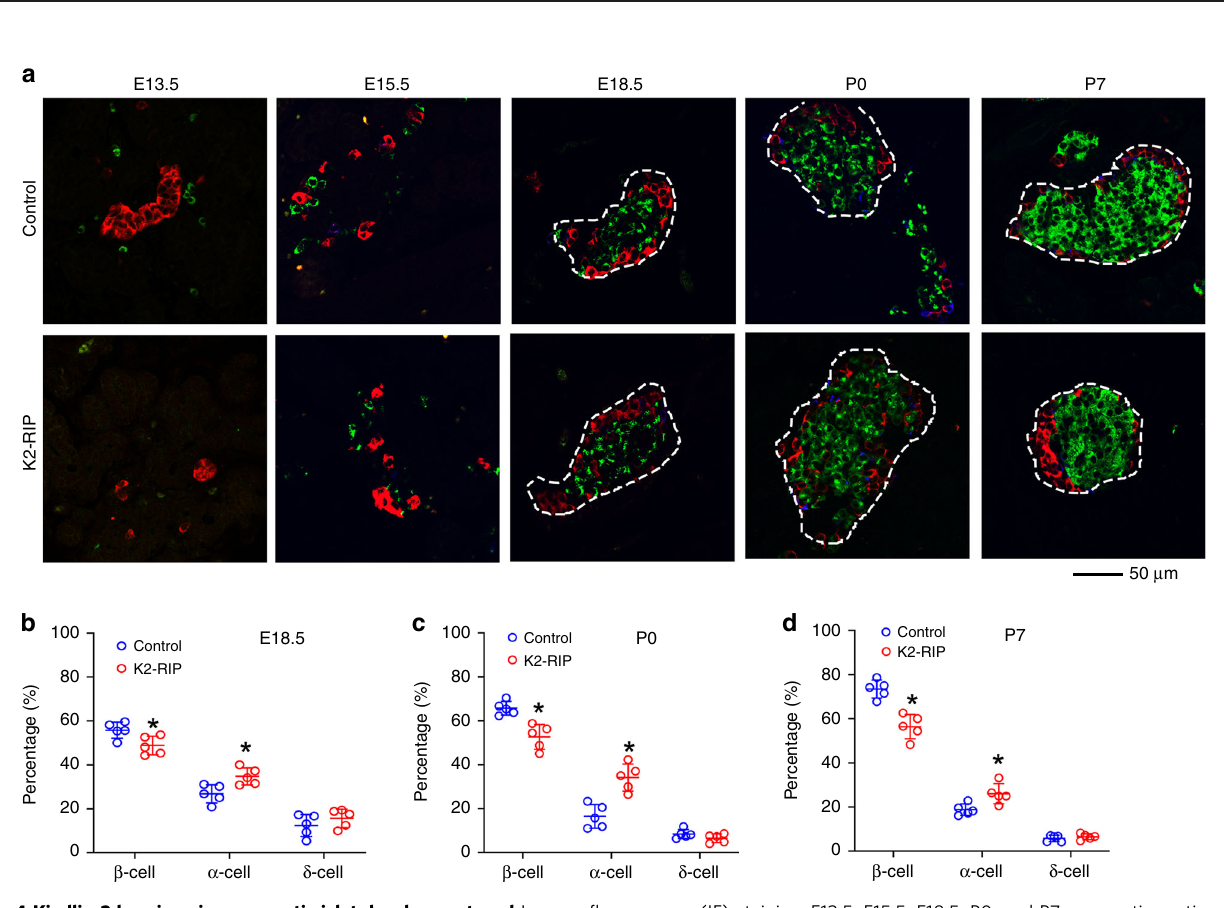
Fig. 4 Kindlin-2 loss impairs pancreatic islet development. a – d Immuno fl uorescence (IF) staining. E13.5, E15.5, E18.5, P0, and P7 pancreatic sections of control and K2-RIP mice were subjected to IF staining using antibodies against insulin (for β -cell), glucagon (for α -cell), somatostatin (for δ -cell), or DAPI (not shown). Pictures were captured ( a ) and the total number of α -cells (red), β -cells (green), and δ -cells (blue) counted and expressed as percentages of total cells in islets ( b – d ). We measured the islet cell composition from 22 to 34 islets per mouse. We analyzed islets from two sides (each slide had 3 – 5 pancreatic sections on it) from each mouse and obtained an average value from each slide. Thus, we obtained two data points for each mouse. For statistical analysis, we used the average value of those two data points for each mouse. N = 5 mice per genotype at all time points. Scale bar, 50 μ m. * P < 0.05, versus control, Student ’ s t test. Because islets were not completely formed in E13.5 and E15.5 mouse pancreatic tissue, we were unable to accurately de fi ne the borders of the islets and did not determine the islet composition at those two time points. Results are expressed as mean ± standard deviation. Source data for b – d are provided as a Source Data fi necessary for interaction with MafA, we generated several the Ins1 promoter. The Kindlin-2 mutant with the N-terminal deletion mutants of Kindlin-2 (Fig. 5l) and tested for their aa 1 – 569 deletion effectively activated the Ins1 promoter. ability to activate Ins1 promoter in the presence of MafA and Consistent with this functional data, deletions of Kindlin-2 observed a major drop in promoter activation when the C- from aa 239 or 570 to aa 680 completely abolished the for- terminus of Kindlin-2 (aa 570 to aa 680) was deleted (Fig. 5m). mation of the Kindlin-2-MafA complex (Fig. 5n). Likewise, Further deletion to aa 239 did not exacerbate the activation of deletion of aa 1 to aa 569 did not abrogate the interaction